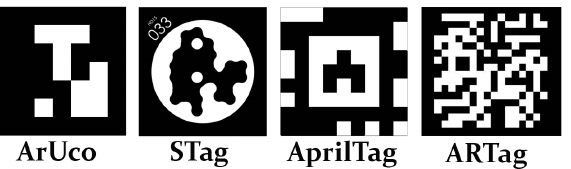
Figure 2. Fiducial marker (Sources to generate: ArUco: https://chev.me/arucogen/, STag: https: //github.com/bbenligiray/stag, AprilTag: https://github.com/AprilRobotics/apriltag and ARTag: https://shawnlehner.github.io/ARMaker/, accessed on 15 January 2023) comparison between ArUco Stag, AprilTag, and ARTag [35].